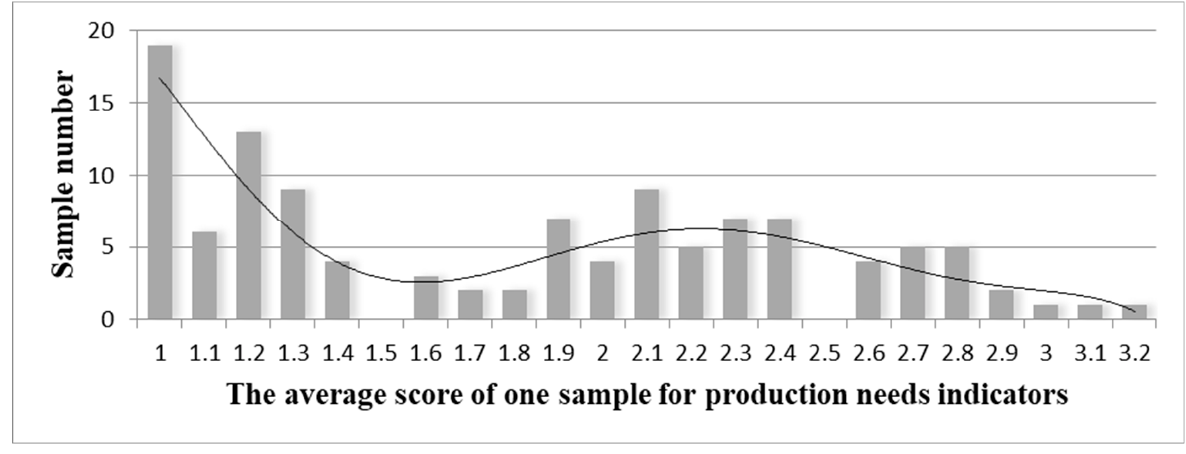
Figure 2. Frequency distribution based on the average score of one sample for production needs.